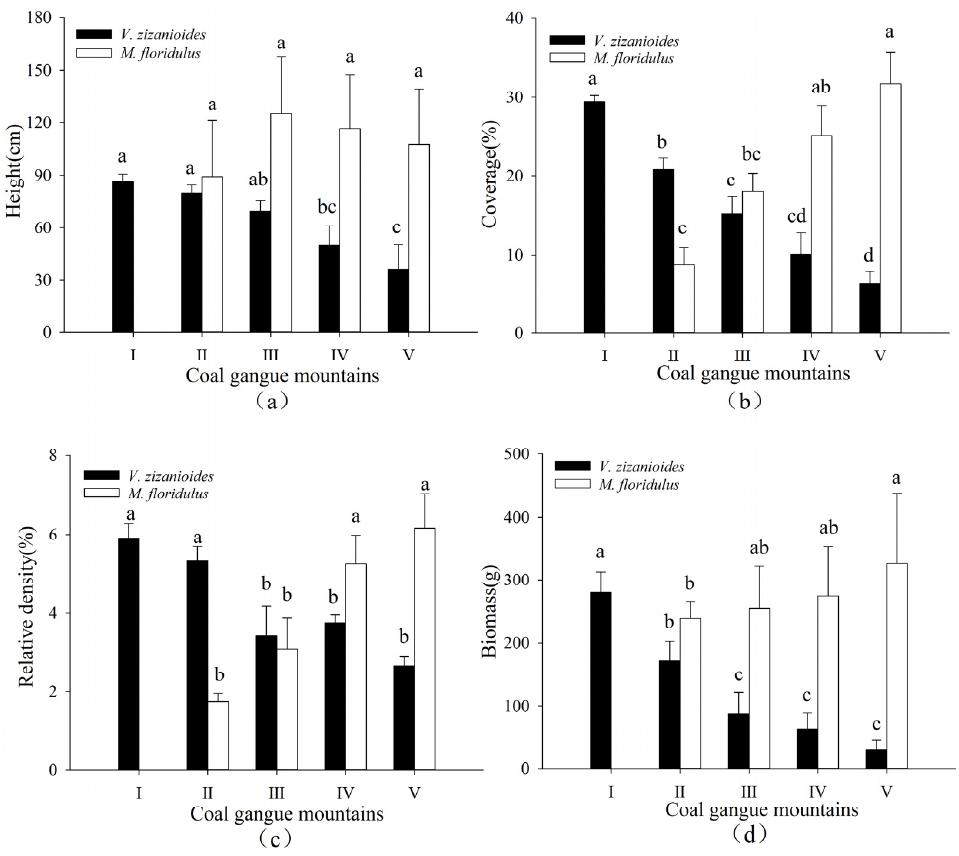
Figure 3. The height ( a ), coverage ( b ), relative density ( c ), and biomass ( d ) of V. zizanioides and M. floridulus in different coal gangue mountains. (Note: Different lowercase letters indicate significant differences at the level of 0.05. “I”, “II”, “III”, “IV”, and “V” correspond to 3, 6, 8, 10, and 13 years after planting, respectively).